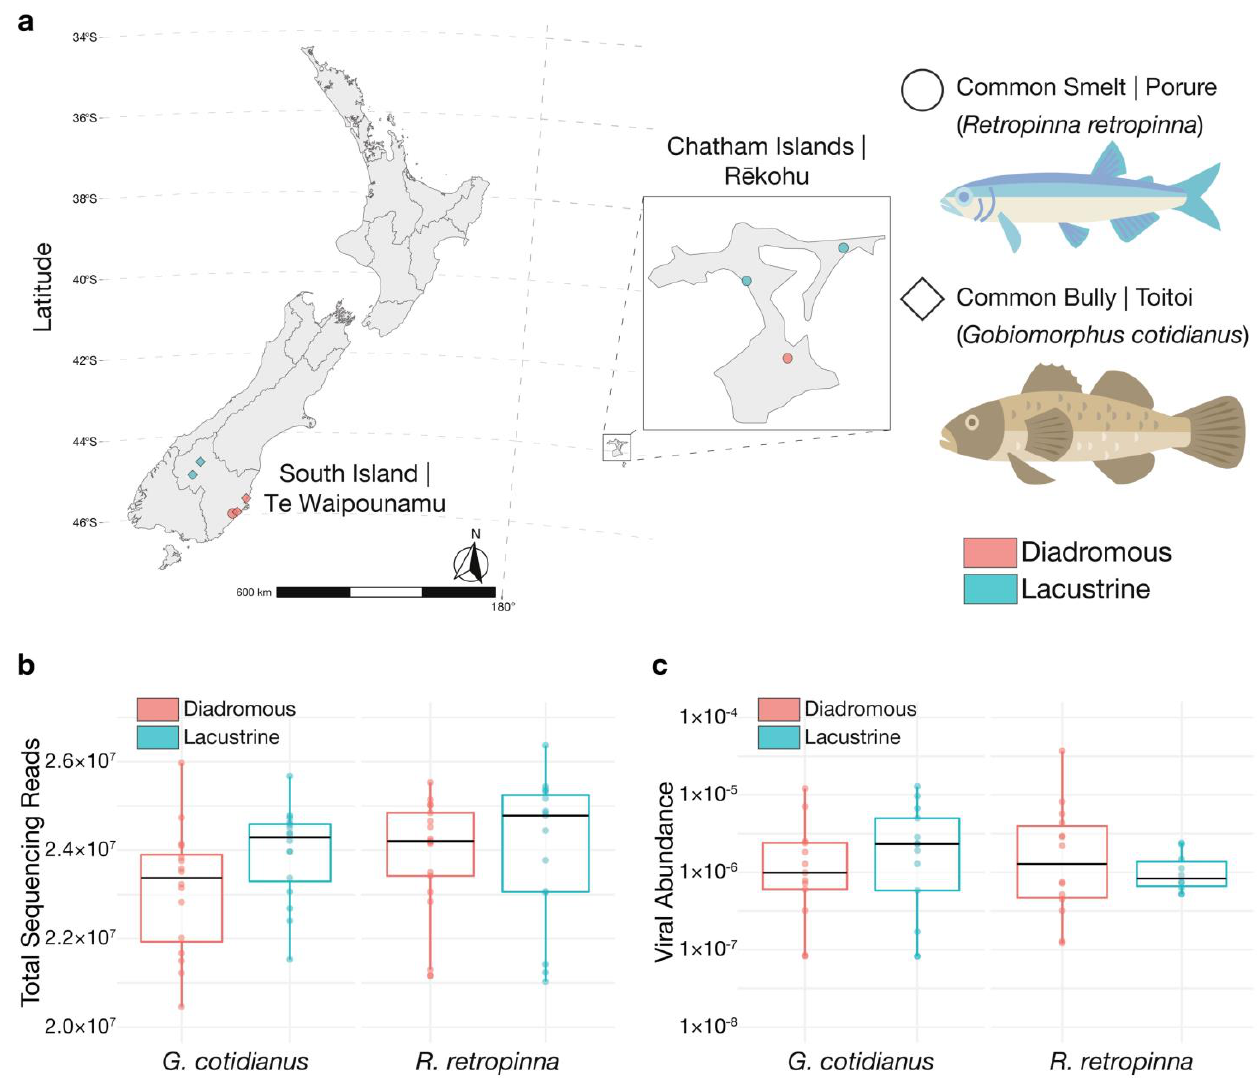
Figure 1. ( a ) Sampling locations for R. retropinna and G. cotidianus collected on the South Island and Chatham Islands of New Zealand. Fish life-history is indicated as diadromous or lacustrine. ( b ) Total paired-end sequencing reads for gill-tissue meta-transcriptome libraries. ( c ) Standardised abundance estimates of viral transcripts identified in gill-tissue meta-transcriptome sequencing libraries. Fish illustrations by Hamish Thompson.